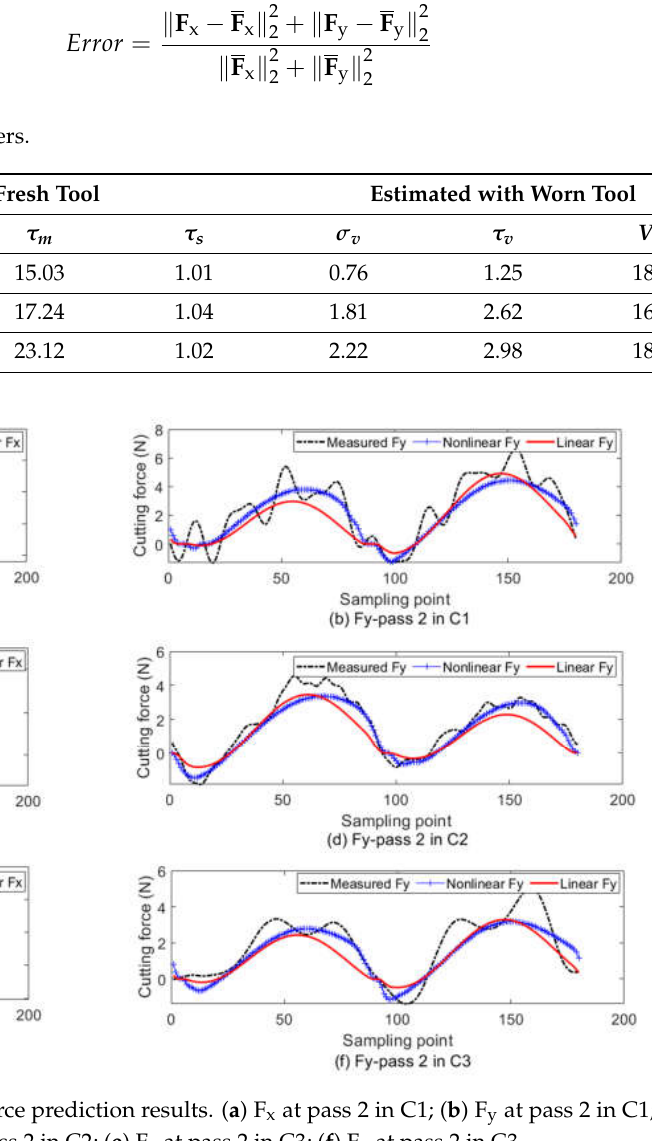
Table 5. The error of cutting force